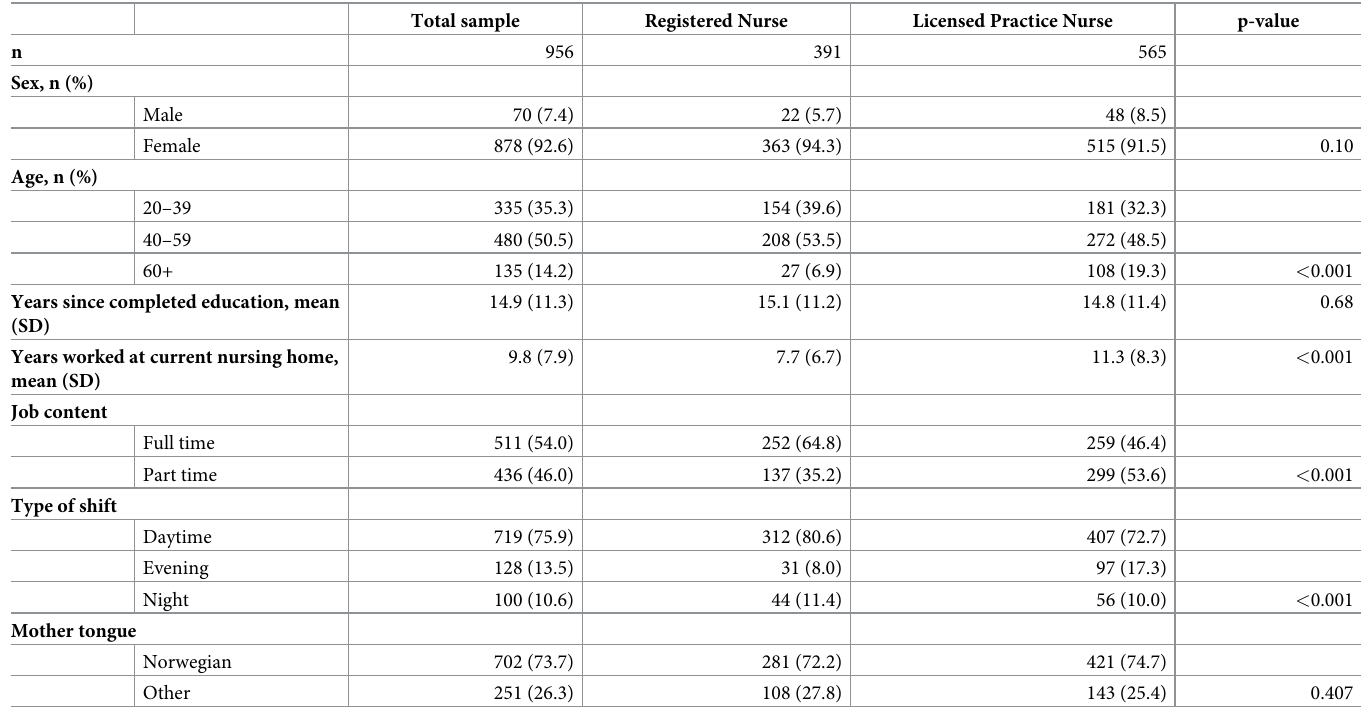
Table 1. Demographic characteristics of the RNs and LPNs (N =